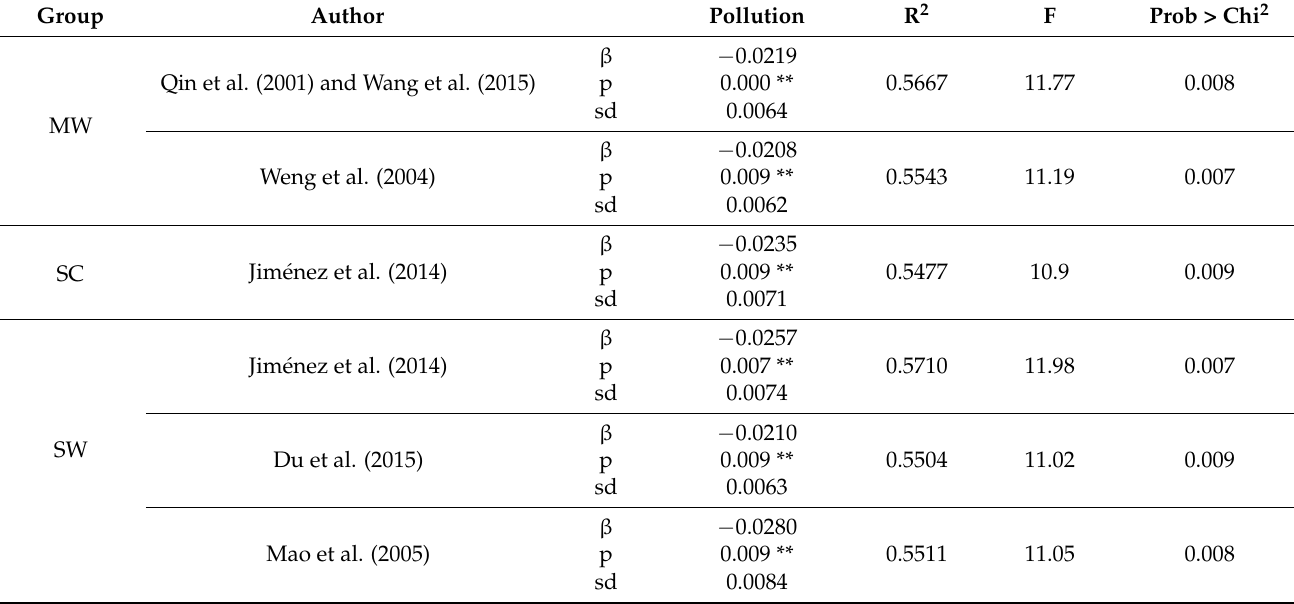
Table 10. Results of the statistical analysis between LST and contamination by algorithm. Group